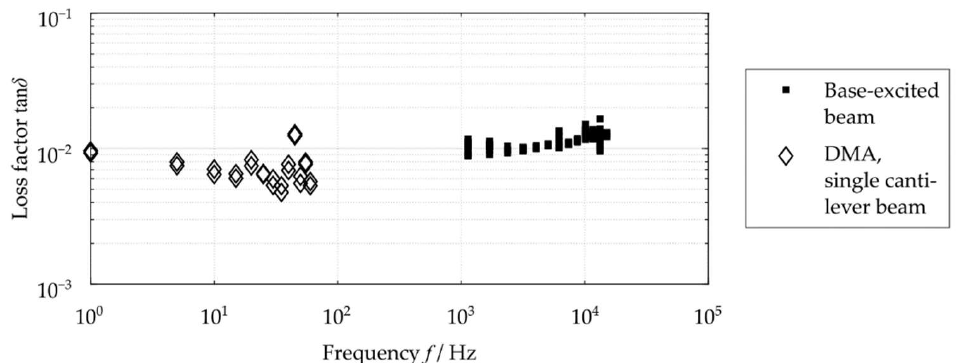
Figure 9. Frequency dependence of the mechanical loss factor tan𝛿 based on dynamic mechanical analysis (DMA) and the evaluation of the base-excited beam’s damping behavior.